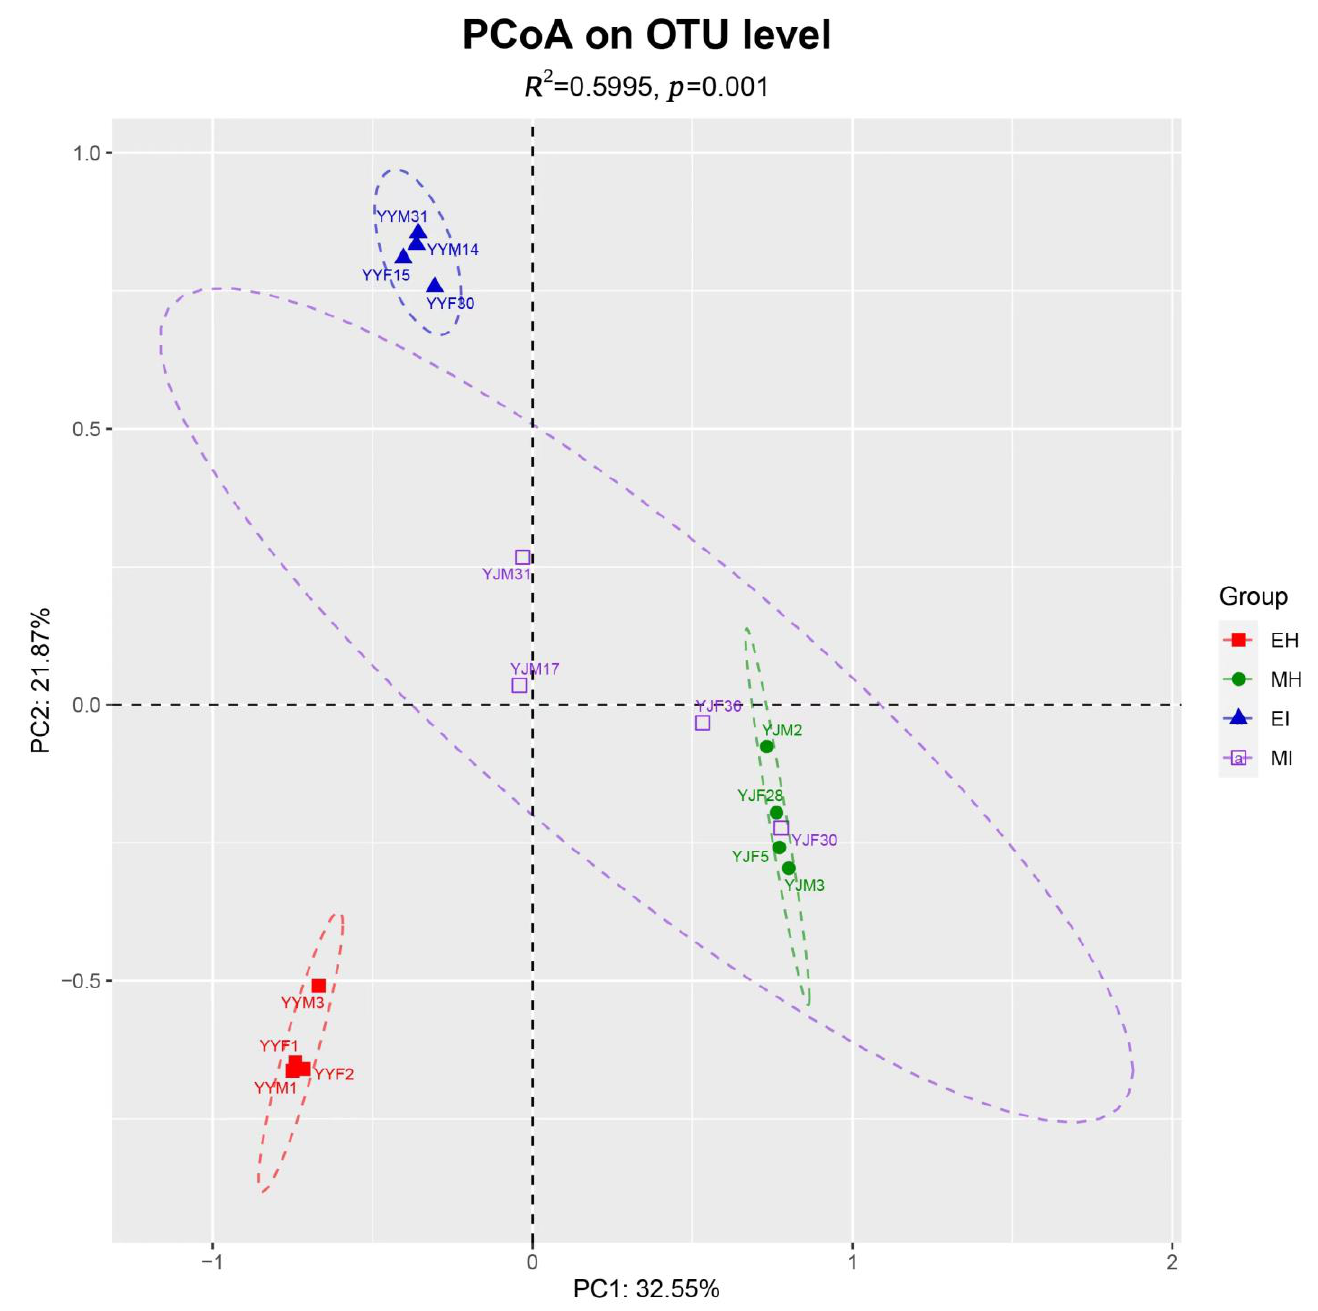
Figure 2. Principal coordinate analysis based on Bray-Curtis distances generated from the OTU table. Differently colored ovals represent different groupings. (EH: emergence period, healthy; EI: emergence period, infested; MH: mating period, healthy; MI: mating period, infested).